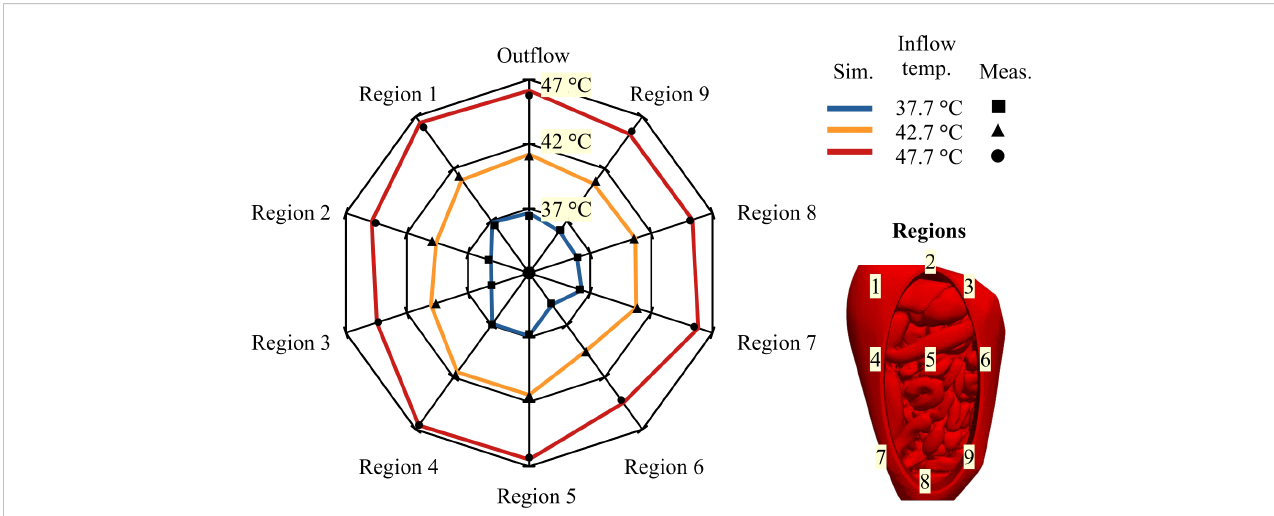
FIGURE 8 Web diagram showing the average steady state temperature for different in fl ow temperatures. Measured temperatures are visualized by a ■ , ▲ and (cid:129) for in fl ow temperatures of 37.7°C, 42.7°C and 47.7°C, respectively. Simulated temperatures are represented by a blue, orange and red lines for in fl ow temperatures of 37.7°C, 42.7°C and 47.7°C, respectively. Similar distributions are visible for all in fl ow temperatures. Region 1, 4, 5 and the out fl ow are all close to the in fl ow temperature while region 2, 3 and 6 are well below the in fl ow temperature. Ideally, all temperatures would approach their respective upper levels, e.g. 37°C, 42 text degree C and 47°C.